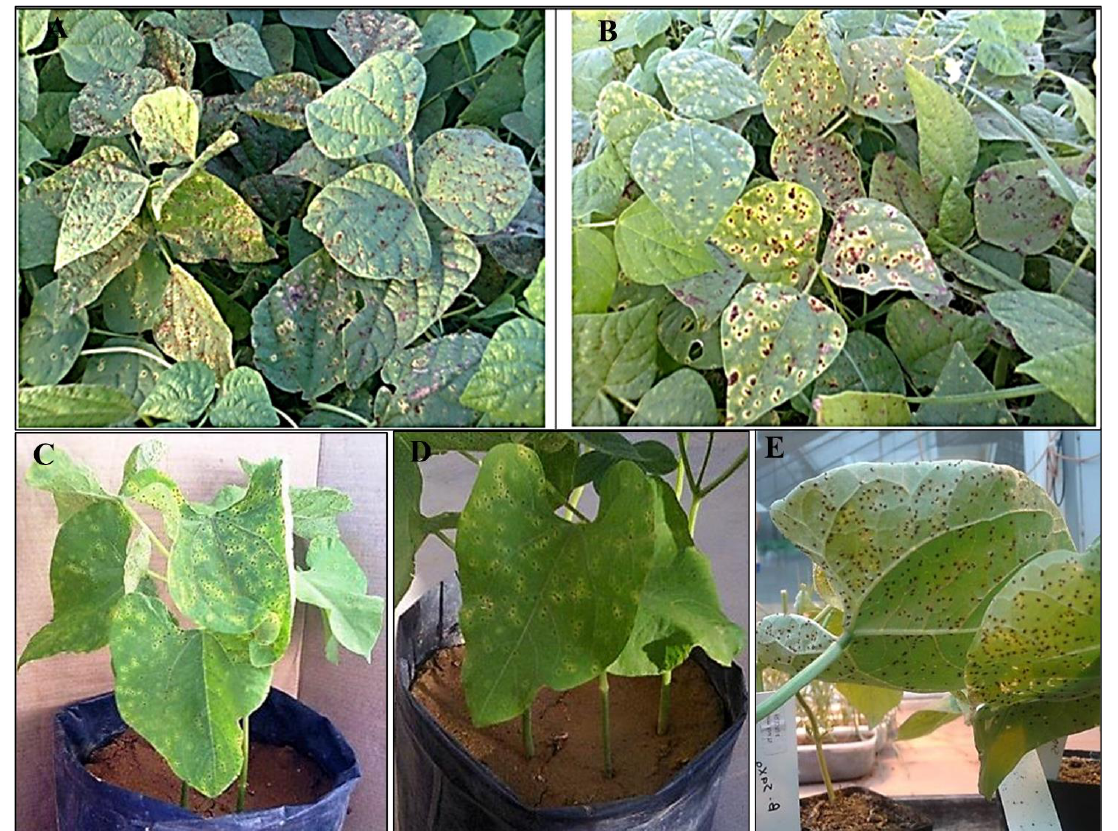
Figure 1. Common bean rust disease caused by Uromyces appendiculatus . ( A , B ) Naturally infected plants showing the symptoms of the rust disease; ( C – E ) Pathogenicity test exhibiting the ability of uredospores to re-infect the plants under greenhouse conditions. Developing of uredial lesions on the upper ( C , D ) and lower epidermis ( E ) of bean leaves.